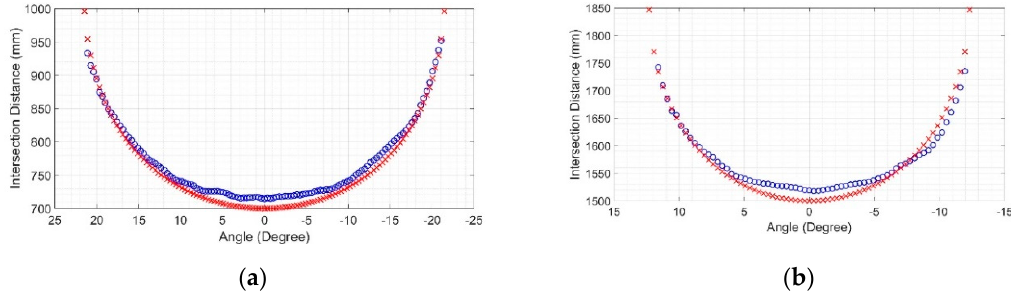
Figure 8. Intersection maps: ( a ) At 700 mm of the sensor’s central ray; ( b ) At 1500 mm of the sensor’s central ray. In both plots, the intersection points of the Hokuyo LiDAR are marked with “o”, while those of the Sensor Simulator (measurement model) are marked with ‘x’ [29].